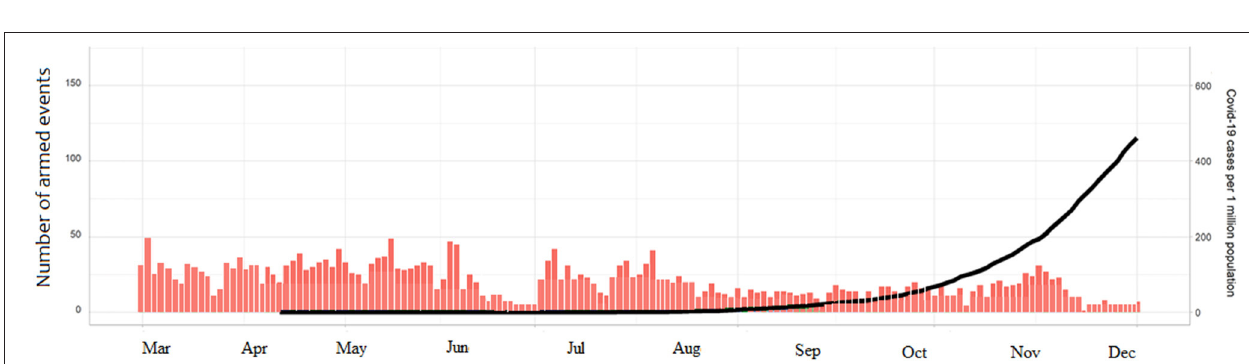
FIGURE 7 | Map of Yemen showing the zones of the armed conflict and areas controlled by each fighting group during 2020.